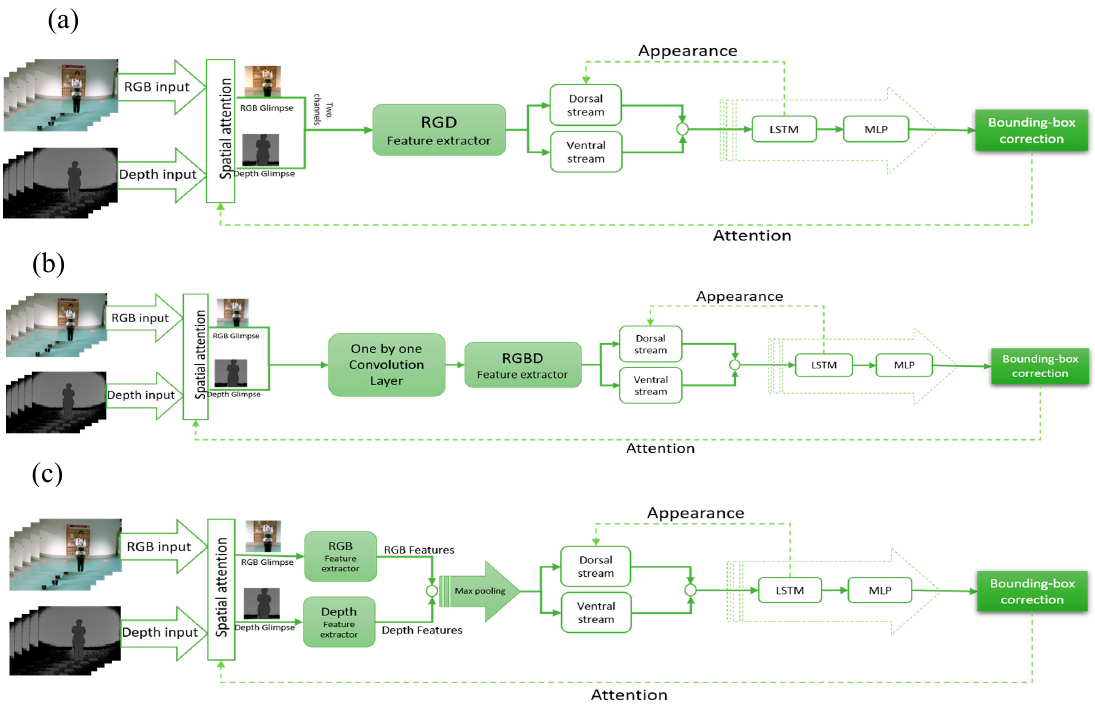
Figure 3. ( a ) RGD Tracker model, ( b ) RGBD combined tracker model, and ( c ) RGBD parallel tracker model.